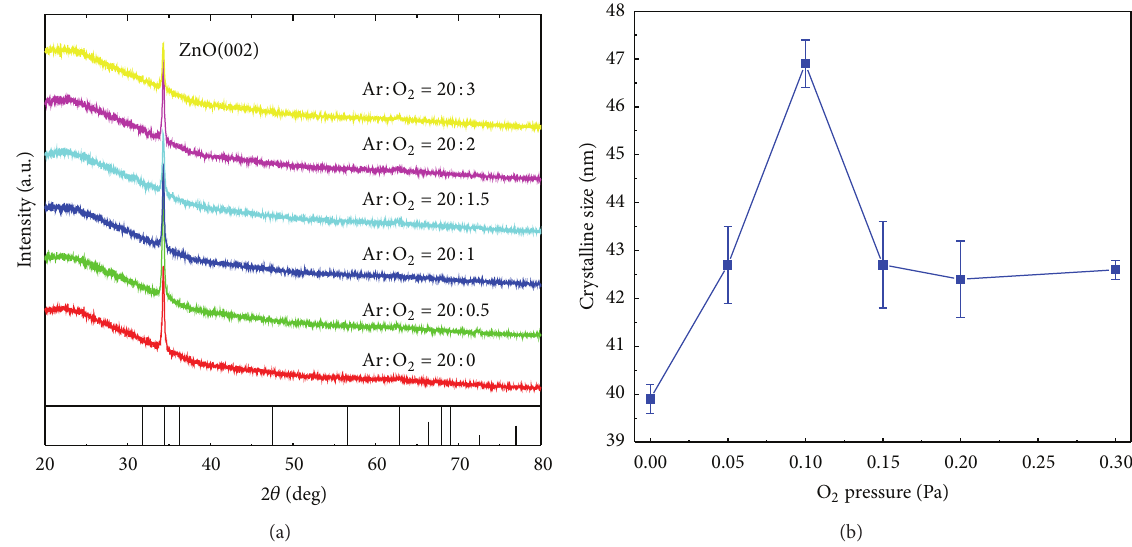
Figure 1: (a) XRD patterns of ZnO polycrystalline thin films deposited under different oxygen partial pressure; (b) the average grains diameters as a function of oxygen partial pressure estimated by the Scherrer equation.